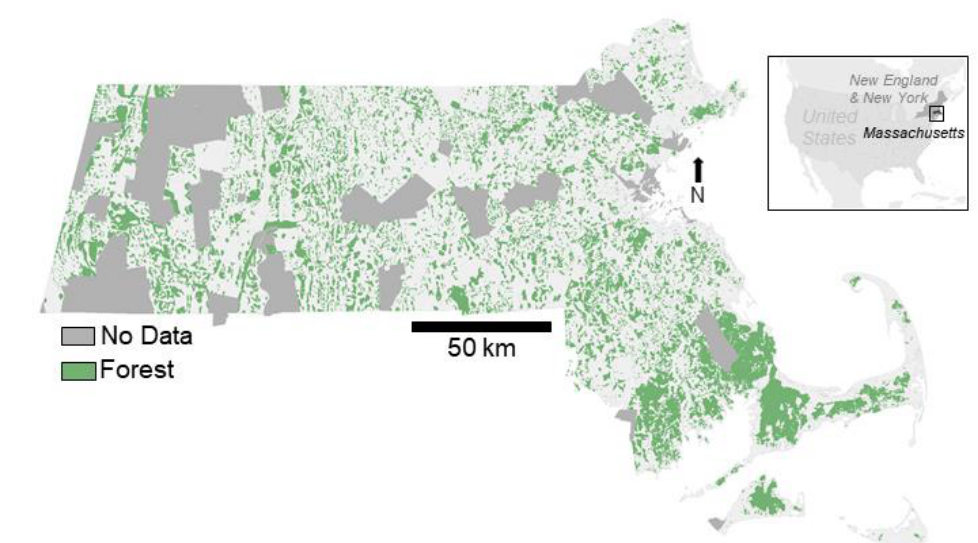
Figure 4. 1830 forest cover in Massachusetts from the Harvard Forest dataset digitized from 1830 archival maps [57] (also see [34], Figure 6 on p.1327). Towns in dark gray do not have any data. Map projection is NAD 1983 UTM Zone 18N.